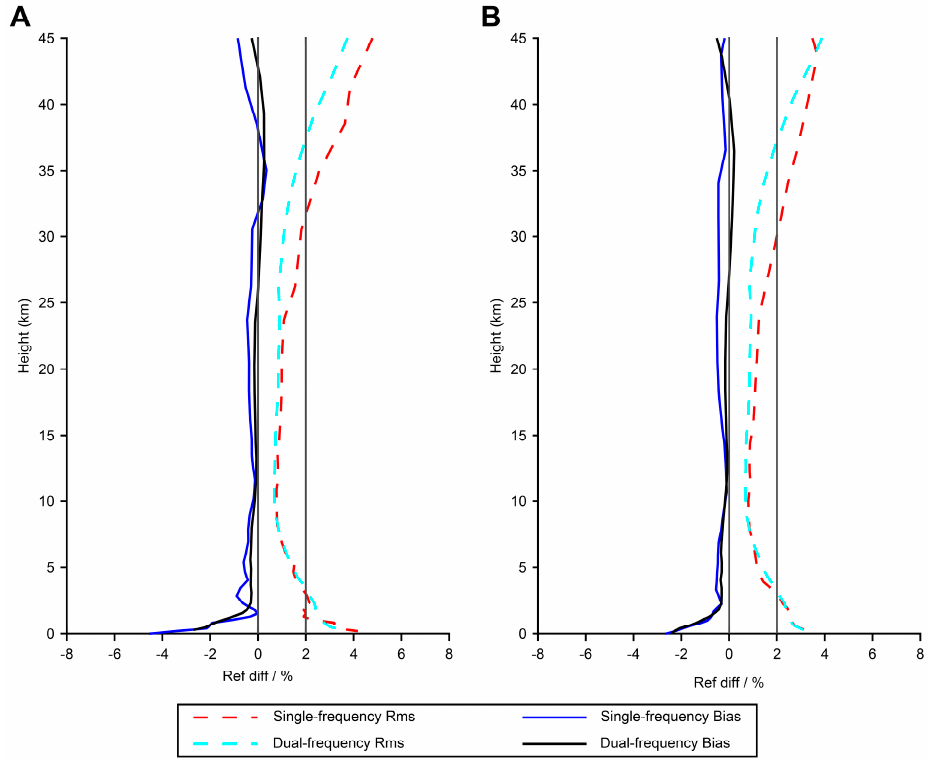
Figure 8. Deviation degree between single-frequency reconstruction and dual-frequency refractive index products and ERA5 products, ( A ) is occultation event 1 and ( B ) is occultation event 2. To sum up, the standard deviation of the single-frequency inversion of refractive index is slightly lower than that of dual-frequency inversion over 25 km, but the system deviation of the single-frequency reconstruction and that of the dual-frequency observation inversion of the refractive index are basically the